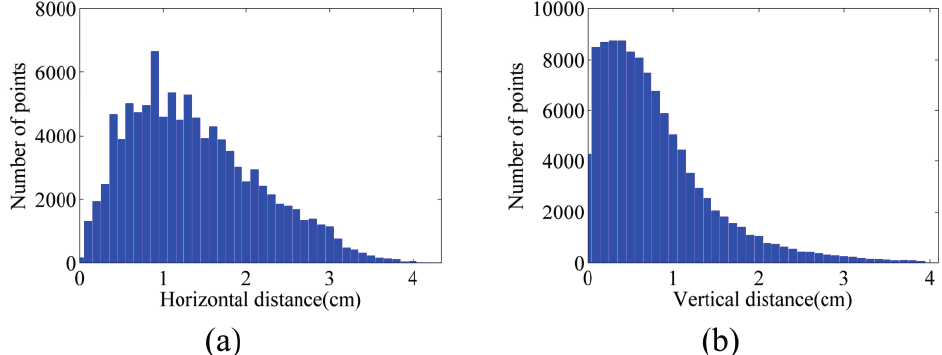
Figure 18. Histograms of distances between the point clouds from dataset A and laser scanner ( a ) Horizontal distances; ( b ) Vertical